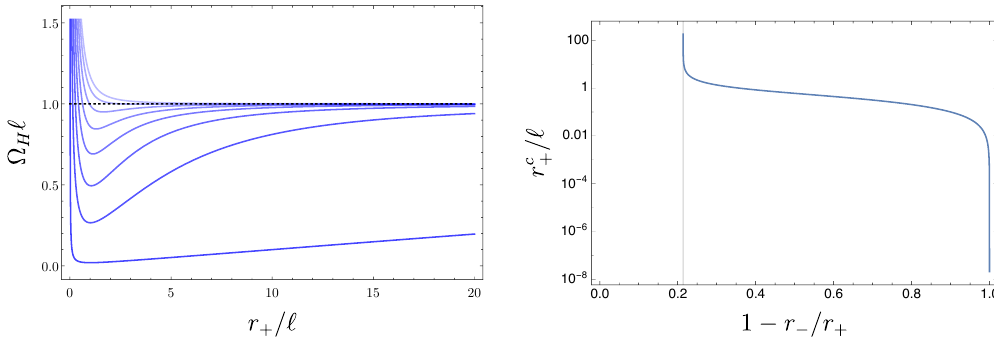
Figure 2. Left: here we show the angular velocity of the horizon as a function of r + /‘ for several values of r − /r + . The curves correspond to r − /r + = 1 / 100 (dark blue, bottom) and increase in increments of 1 / 8 from bottom to top. The dashed black curve corresponds to the critical angular velocity Ω c = 1 /‘ . Right: a plot of the value of r + /‘ at which the black hole rotates superluminally. H √ p √ The vertical line corresponds to r − /r + = 5 − 1 / 2